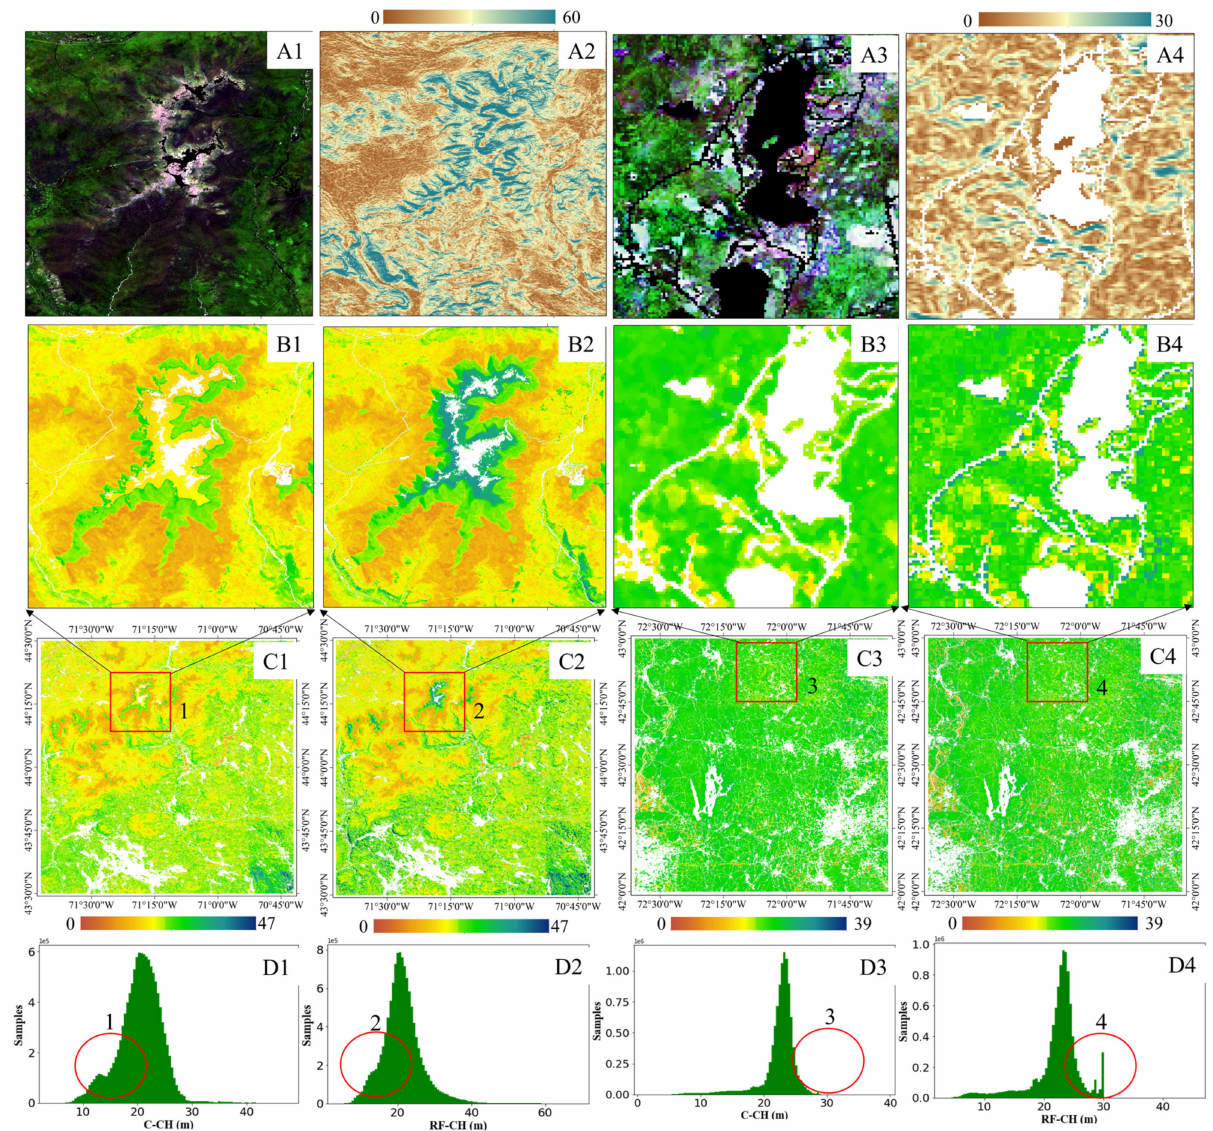
Figure 8. Comparison of distributions between C-CH ( C1 , C3 ) and RF-CH ( C2 , C4 ) over space and height histograms. ( A1 , A3 ) are true color images, while ( A2 , A4 ) are topographic slopes for the enlarged rectangle in Area 1 ( B1 , B2 ) and Area 2 ( B3 , B4 ). ( D1 – D4 ) represents histograms of canopy height of C-CH ( D1 , D3 ) and RF-CH ( D2 , D4 ) in Area 1 ( D1 , D2 ) and Area 2 ( D3 , D4 ), respectively. The red circles in ( D1 – D4 ) show the obvious difference between the canopy heights of RF-CH and C-CH. The true color images are composited with the blue, green, and red bands of Sentinel-2. Masked areas are displayed in